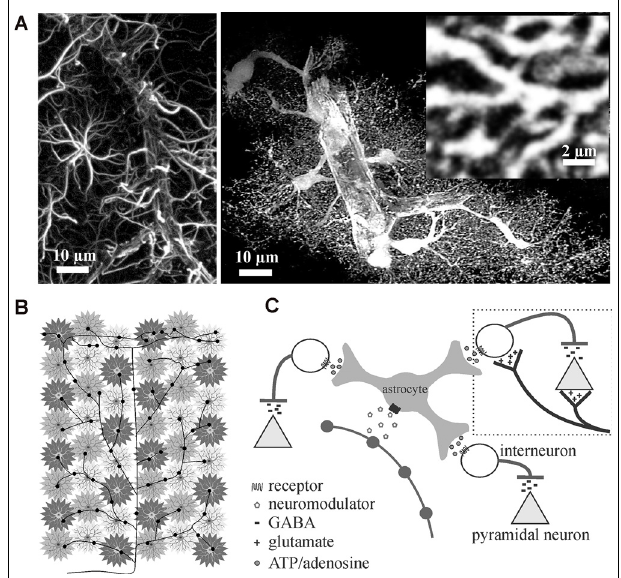
FIGURE 1 | Astrocytes are ideally situated to extend neuromodulators’ influence over cortical inhibition to multiple synapses. (A) Traditional glial fibrillary acidic protein (GFAP) immunolabeling in the rat cortex (left image) only outlines major processes giving them their star-like shape. In contrast, cytosolic enhanced green fluorescence protein expression in astrocytes reveals their highly complex and delicate morphology in situ (right image). Astrocytes consist of numerous fine processes that form a matrix-like substrate (inset) that is in close apposition to axons, dendrites, synapses, and cell bodies. Images adapted from Simard and Nedergaard (2004) with permission. (B,C) Conceptual representation of a single locus coeruleus norepinephrine neuron, projecting from the corpus callosum through to the surface of the cortex, illustrating how volume release can affect individual astrocyte regulated synaptic islands for rapid and wide-spread